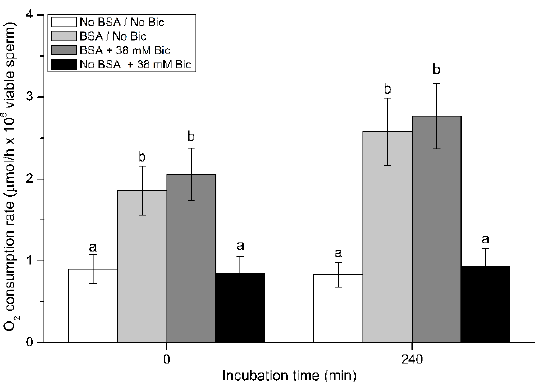
Figure 9. O 2 consumption rate of pig sperm in the presence of different concentrations of bicarbonate (Bic; 0 mM, 38 mM) and BSA (0, 5 mg/mL) at 0 min and 240 min. Different superscripts (a,b) indicate significant differences ( p < 0.05) between treatments within the same time point. Results are shown as mean ± SEM for 12 independent experiments.